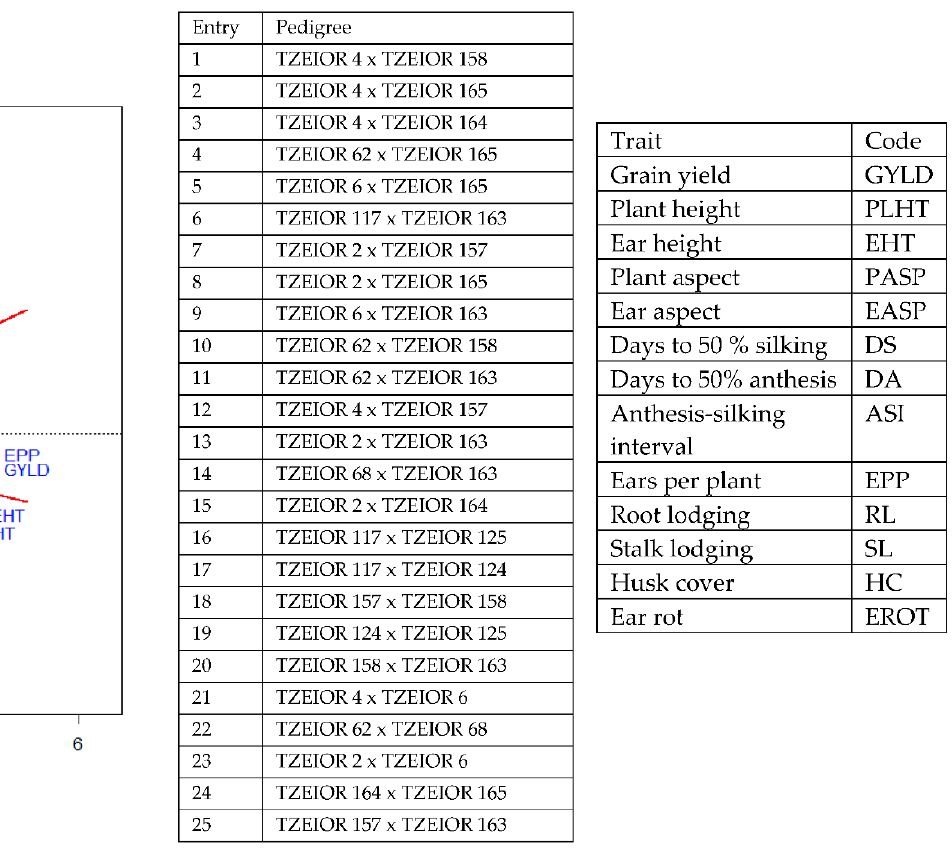
Figure 7. A polygon view of genotype by trait showing top 15 hybrids and the least 10 hybrids among the 196 testcrosses evaluated under optimal conditions at Bagauda, Kadawa, Abuja, Ikenne and Mokwa, Nigeria in 2016 and 2017. The biplot was based on genotype-focused singular value partitioning (‘SVP = 2). Principal component (axis 1) and axis 2 for model 2 explained 64.76% of the variation among traits.